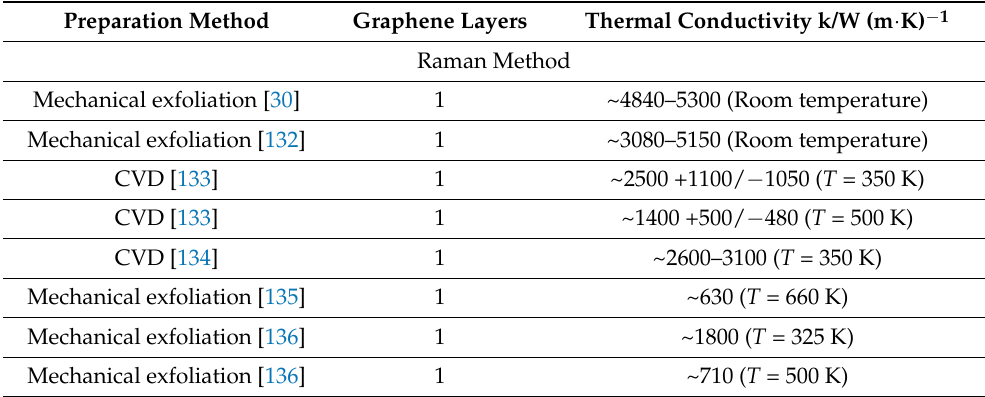
Table 1. Experimental detail of thermal conductivity in suspended single-/few-layer graphene from different